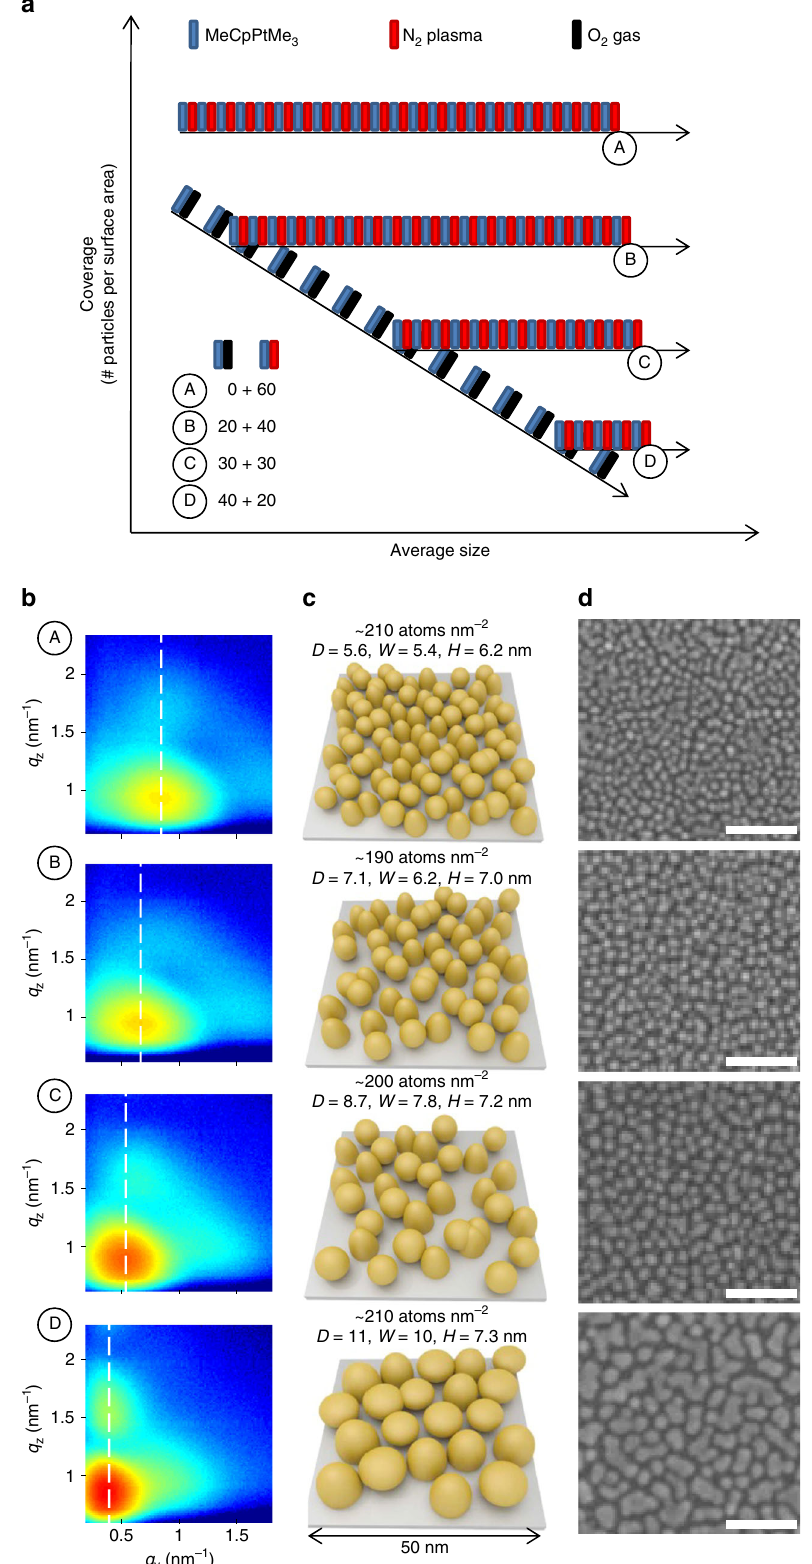
Fig. 6 Precise control of coverage of Pt nanoparticles using ALD. Tuning the particle coverage at a fi xed Pt loading by combining 0 (sample A), 20 (sample B), 30 (sample C), and 40 (sample D) O 2 -based Pt ALD cycles with 60 (sample A), 40 (sample B), 30 (sample C), and 20 (sample D) N 2 * -based Pt ALD cycles. a ALD recipe scheme. For clarity, fewer than the real number of ALD cycles are schematically represented. b Experimental 2D GISAXS images. The dashed vertical lines indicate the q y -position of the main scattering lobe. c Schematic representations of the GISAXS results. The Pt loading, mean center-to-center particle distance 〈 D 〉 , average particle width 〈 W 〉 , and average particle height 〈 H 〉 are indicated. d SEM images with 50nm scale